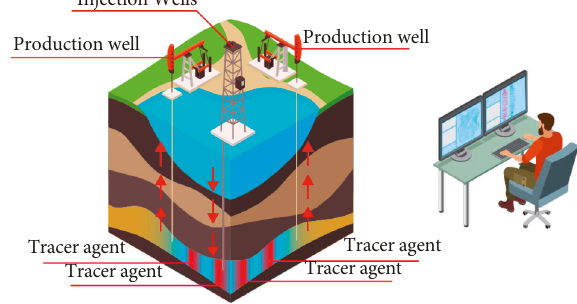
Figure 1: Cross-well nanometre tracer